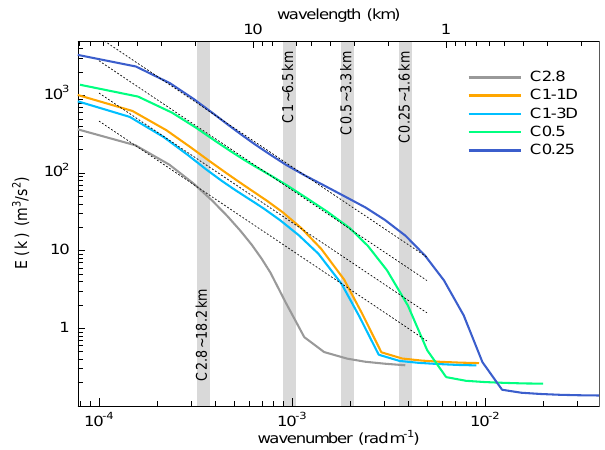
Figure 7. Kinetic energy density spectra computed from COSMO model output for 23 July 2013 averaged between 10:00 and 18:00UTC at a height of 5kma.g.l. The gray shaded areas repre- sent wavelengths of 6–7 times the horizontal grid spacing of the different model runs. Dashed lines with − 5/3 slope are plotted to aid identification of the inertial